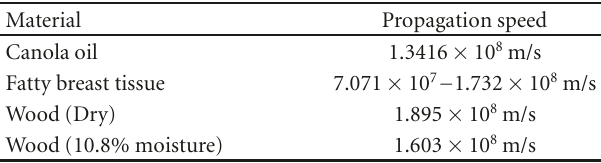
Table 1: Propagation speed values of the materials used in the experimental setups.